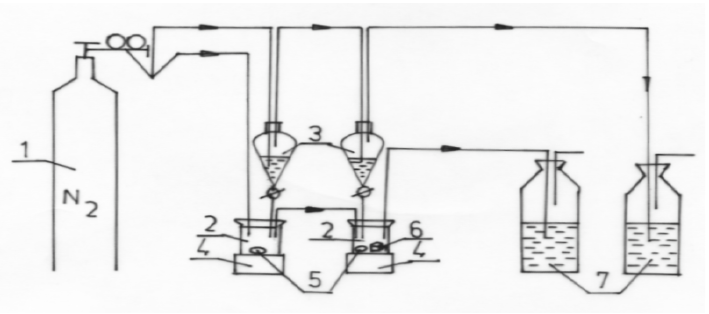
Fig. 1 Assembly for sample dissolution: (1) bottle of nitrogen gas; (2) beakers; (3) funnels; (4) electromagnetic stirrers; (5) stirrer bars; (6) glass container; (7) hydraulic